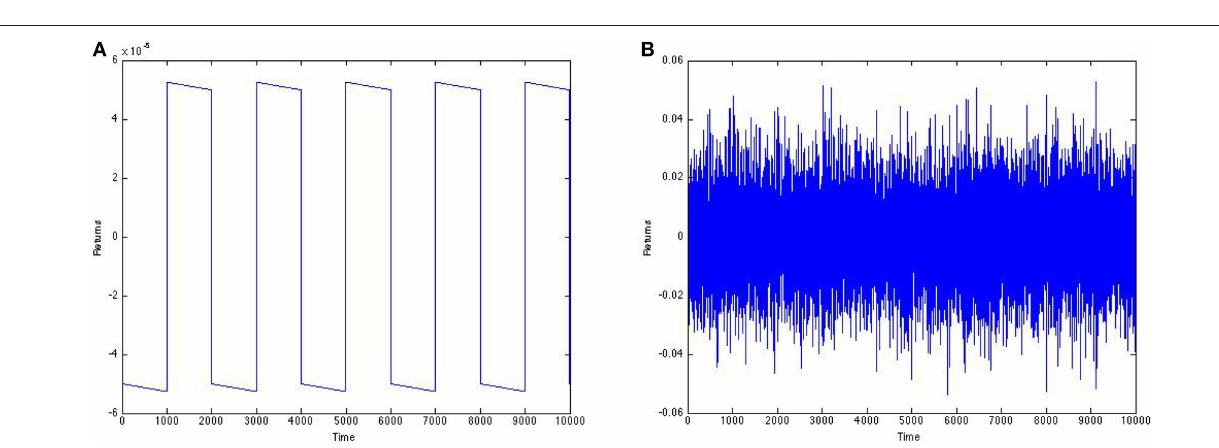
FIGURE 10 | Return signal corresponding to the price signal in Figure 8A before and after noise. (A) Before noise. (B) After